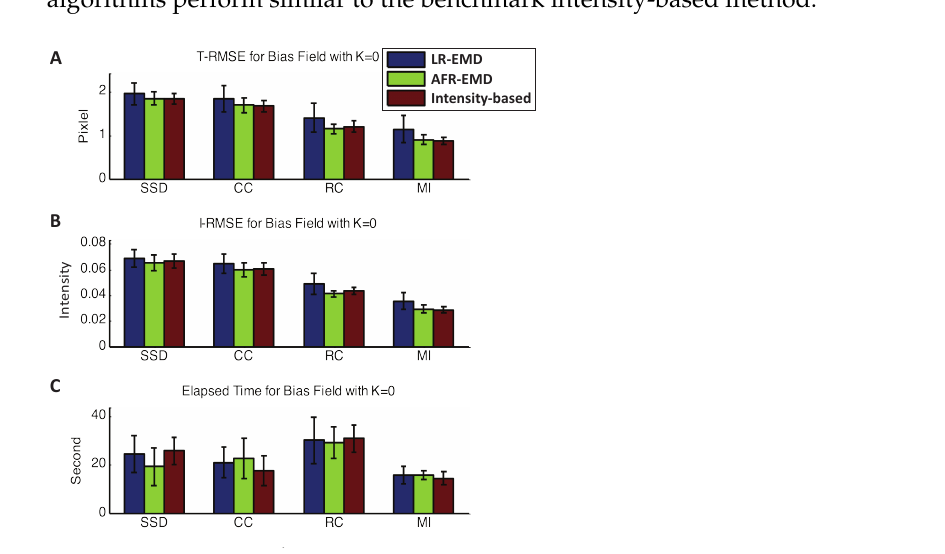
Figure 3. Registration performance when there is no bias field. Mean and variance of T-RMSE and I-RMSE for images in the BrainWeb dataset are shown in ( A , B ) panels. ( C ) panel compares the running time for all